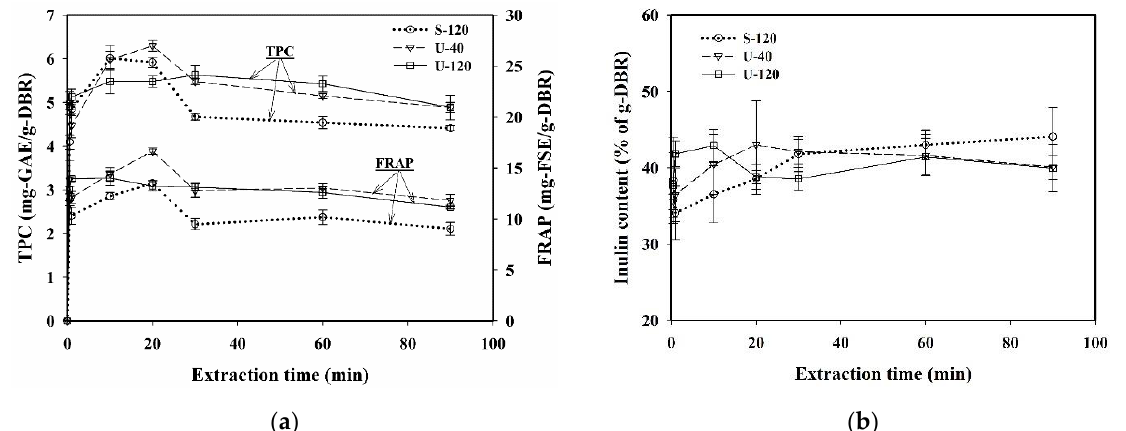
Figure 3. Effect of extraction time on the variations of ( a ) total phenolic content (TPC) and ferric- reducing antioxidant power (FRAP), and ( b ) inulin content. Conditions: 50 °C and 1/30 (g/mL-water) of solid-to-liquid ratio for extraction modes of 120 rpm of shaking (S-120), 40 kHz of ultrasound (U-40), and 120 kHz of ultrasound (U-120). Data were expressed as mean ± standard deviations from triplicate experiments.